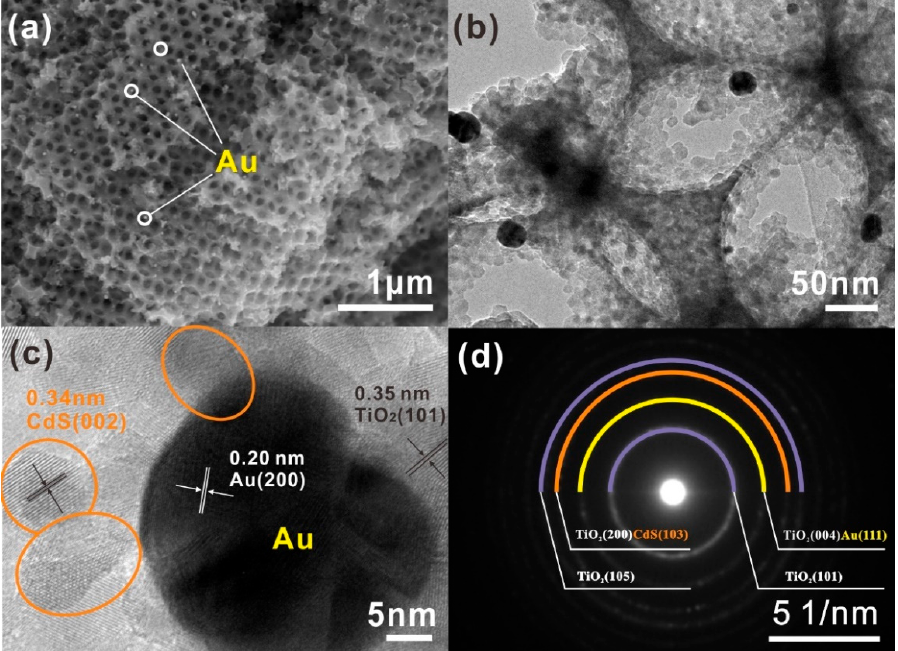
Figure 2. ( a ) Backscattered electron (BSE), ( b ) TEM, ( c ) HR-TEM, and ( d ) SAED images of the 3DOM TiO 2 -Au-CdS photocatalyst.